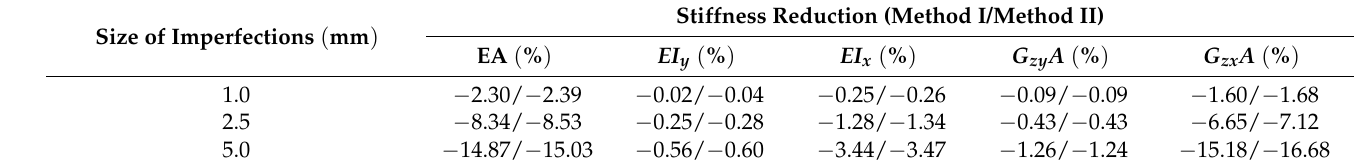
Table 7. Stiffness reduction of the Z profile with elongation of 100 mm due to shearing for case (i), depending on the size of